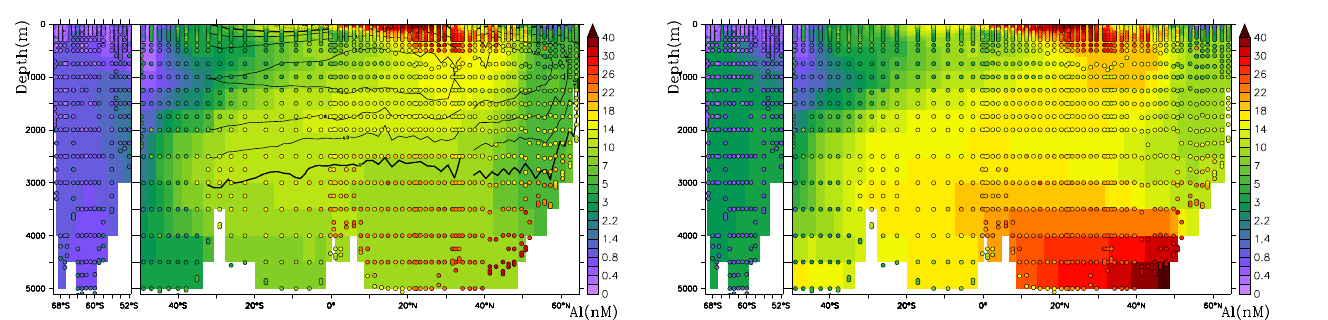
Figure 6. Simulated [ Al diss ] (nM) from the [ Si diss ] -independent sediment resuspension simulation (500 yr after forking) along the Zero Meridian and West Atlantic GEOTRACES transect (SedProp). Observations are represented by the coloured